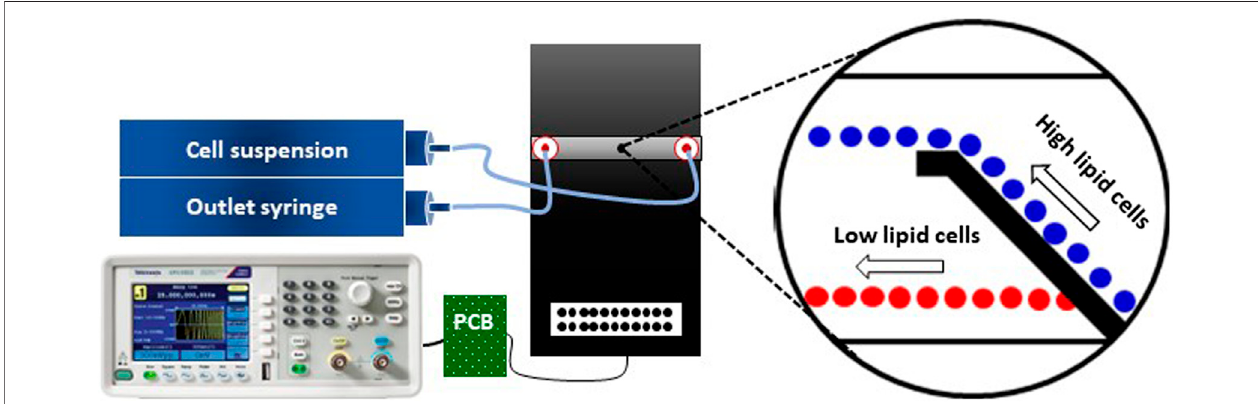
FIGURE 6 | Schematic of the micro fl uidic setup used for C. cohnii separation by DEP. The setup consists of a micro fl uidic fl ow cell (black platform), two syringe pumps(inletandoutlet),aPCBandafrequencygenerator.Thetubingbetweenthesyringepumpsandthemicro fl uidic fl owcellissymbolizedbylightblue-colouredlines and thecables fordelivering theDEP signal are indicated byblack lines. The magni fi ed viewshows the cells ’ behaviour due to theDEP fi eld, inwhich high lipid cells (blue colour) are being repelled at the electrodes edge while low lipid cells (red colour) are passing through the top-bottom electrode structure. For further details see (Boldt et al.,